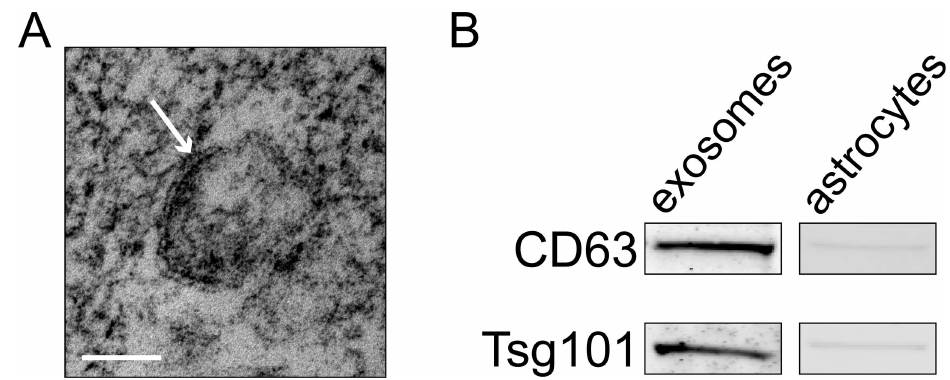
Fig 1. Characterization of extracellular vesicles isolated from astrocyte-conditioned media. A) Transmission electron microscopy revealedpresenceof exosomes, characterized as doublemembrane- bound vesicles(indicatedby arrow), between50 and 100 nm in size. Scale bar = 50 nm. B) Western blot analysisconfirmedexpressionof CD63and Tsg101 in astroglial exosomes,while astrocytes showedvery low levels of expressionof these